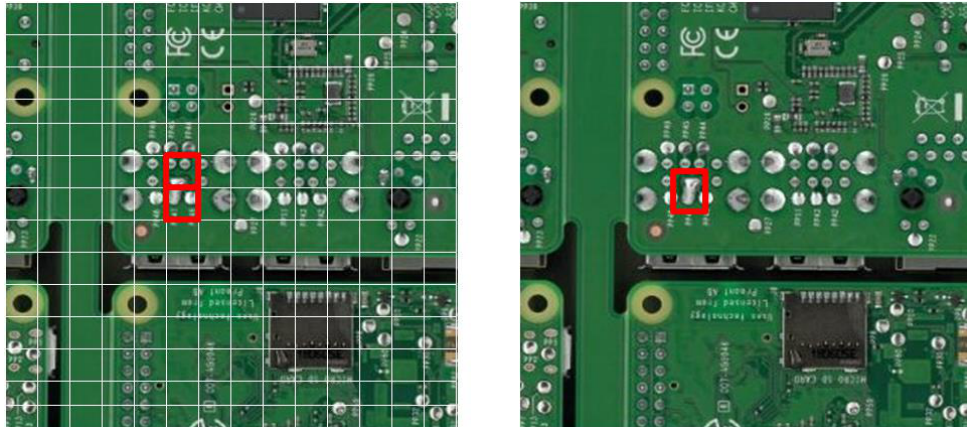
Figure 5. Image on the left: Prediction by Model4, Image on the right: Ground